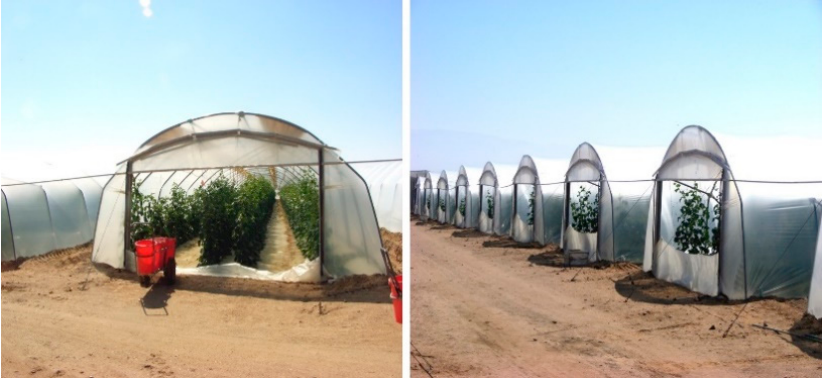
Figure 2. Typical spring and winter melon production systems under plastic greenhouses (720 m 2 each) in the Arava valley of Southern Israel.